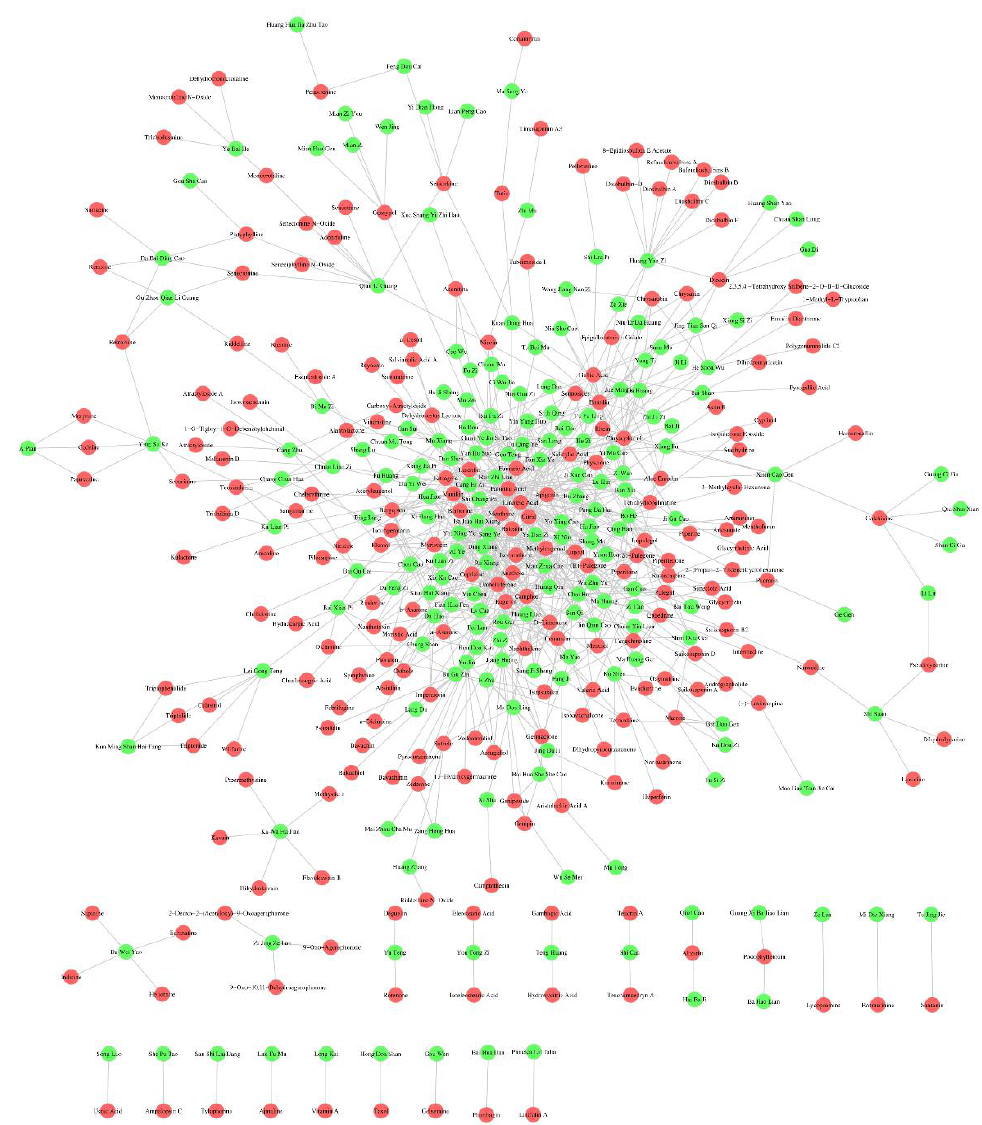
Figure 4. Herb-ingredient network. The green and red circle nodes represented the hepatotoxic herbs and hepatotoxic ingredients, respectively. The gray edges between the herbs and ingredients indicated that the herbs include the hepatotoxic ingredients.